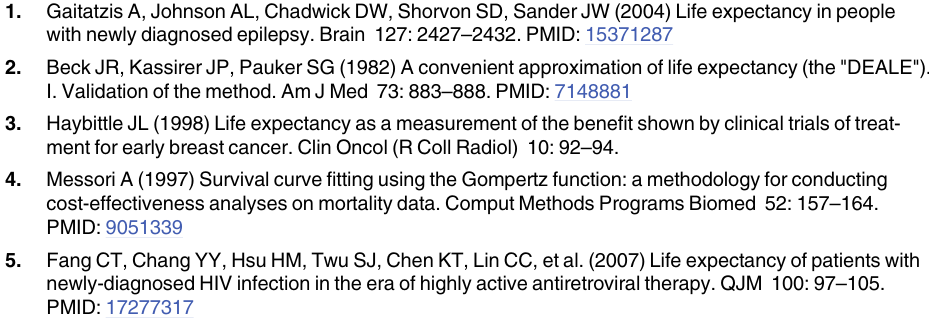
S1 Fig. Survival rates of stage I – IV colon cancer patients. Five-year survival rates were 87.79%, 76.79%, 62.24% and 14.17%, respectively; ten-year rates were 66.80%, 63.23%, 47.11% and 10%,